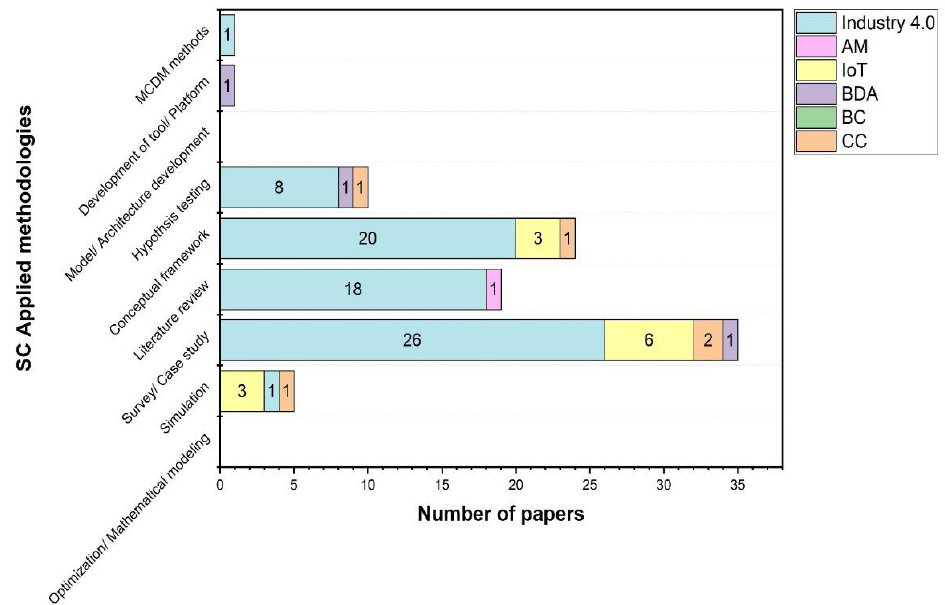
12 of 22 Figure 6. Distribution of papers: SC-associated issues . (c) Supply chain-applied methodologies. Various methodologies are currently applied to address the Lean DSC (Figure 7). To this end, the survey/case study category re- veals as the dominant one for investigating CC, BDA, IoT, and Industry 4.0 in gen- eral, applied together with Lean principles. Additionally, it should be noted that, ex- cept for the work by [71] on AM, there is no paper applying the literature reviews to discuss single digital technologies in relation to Lean Manufacturing. Besides, con- ceptual framework proves to be a popular methodology, applied for debating CC,